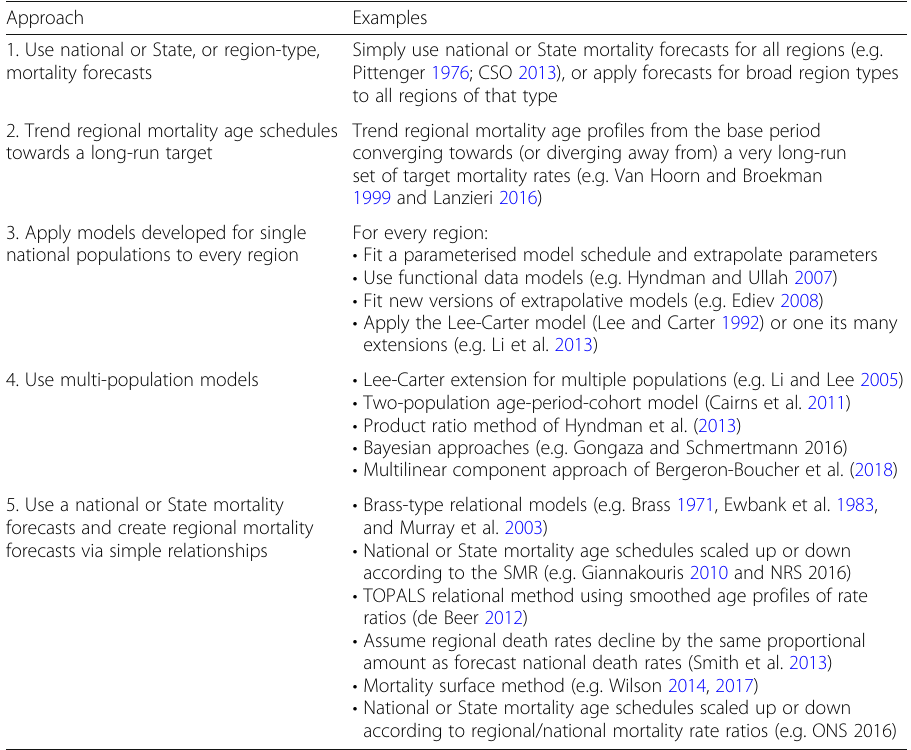
Table 1 Some broad approaches to regional mortality